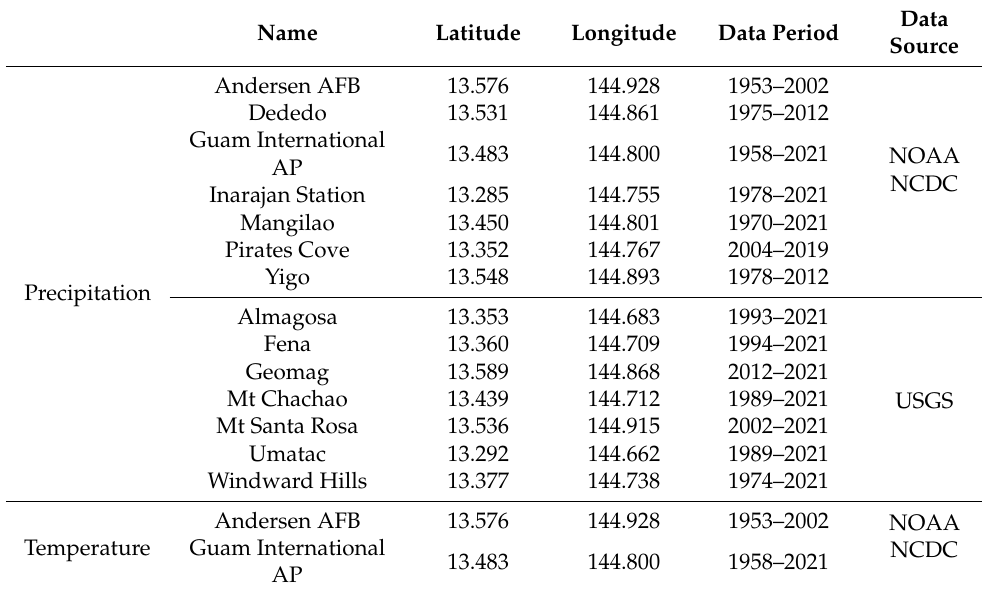
Table 1. List of station, their coordinates, data periods, and data